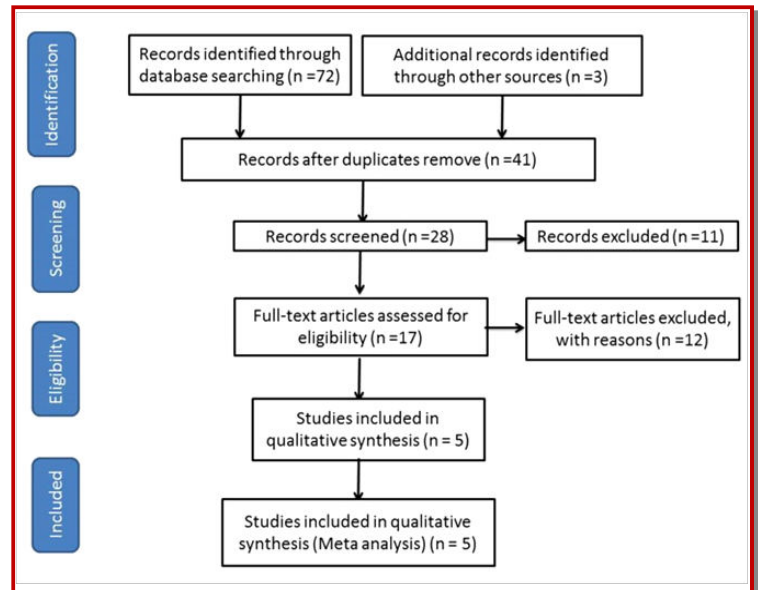
Figure 1: Search results and study data assessment after primary screening. The number of eligible articles dropped to 41 articles through title and